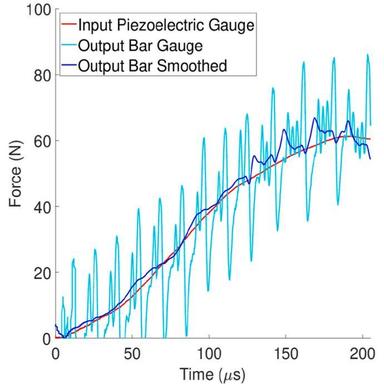
Comparison of data from the piezoelectric gauge at the input-bar specimen interface, and the surface-mounted gauge on the output bar, demonstrating the considerable improvement in data quality from the piezoelectric gauge, and that the specimen is in static equilibrium during the experiment.